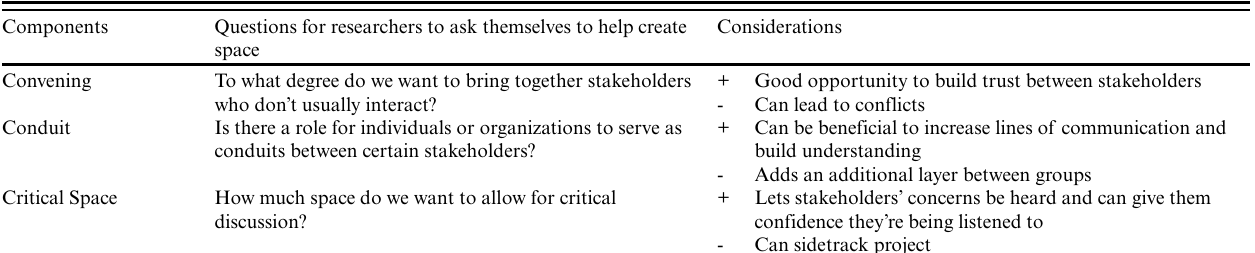
Table 3. Questions and considerations to guide researchers in creating space, derived from the experiences of researchers leading 12 ecosystem services research case studies.